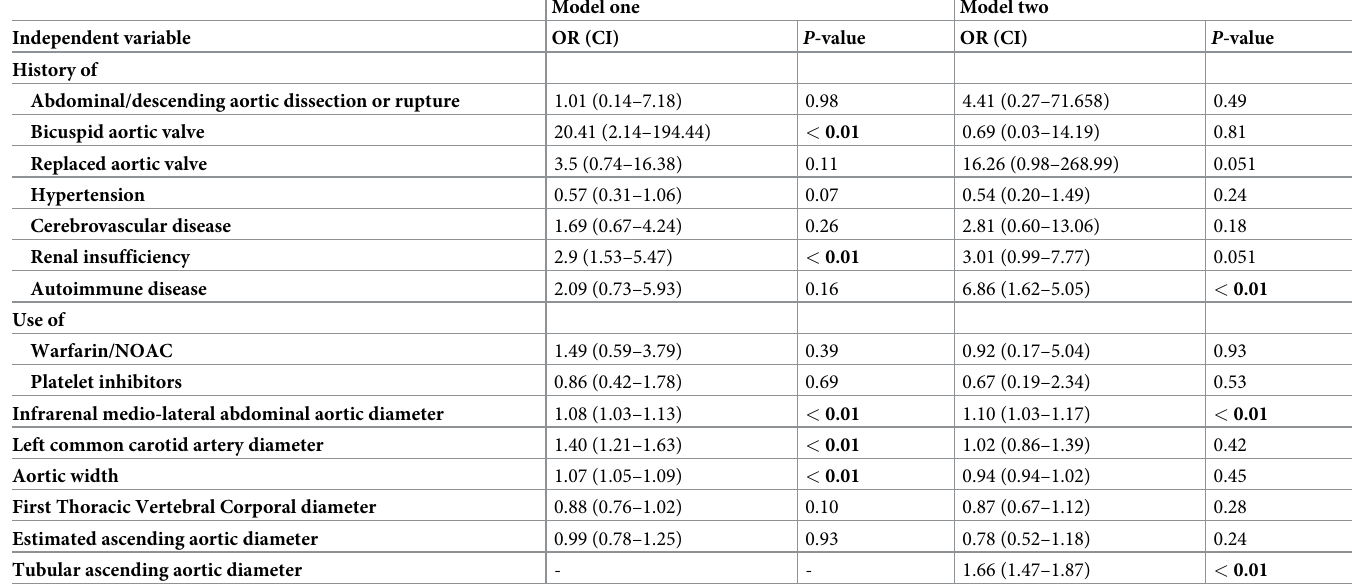
Table 3. Result of multivariate logistic regression analysis model were the presence of acute and chronic aortic syndromes of the ascending aorta is the dependent variable. Renal insufficiency was defined as eGFR < 60. Aortic width is the direct distance from the sinutubular junction to the corresponding point of the descending aorta in the transverse plane. OR = Odds ratio, CI = confidence